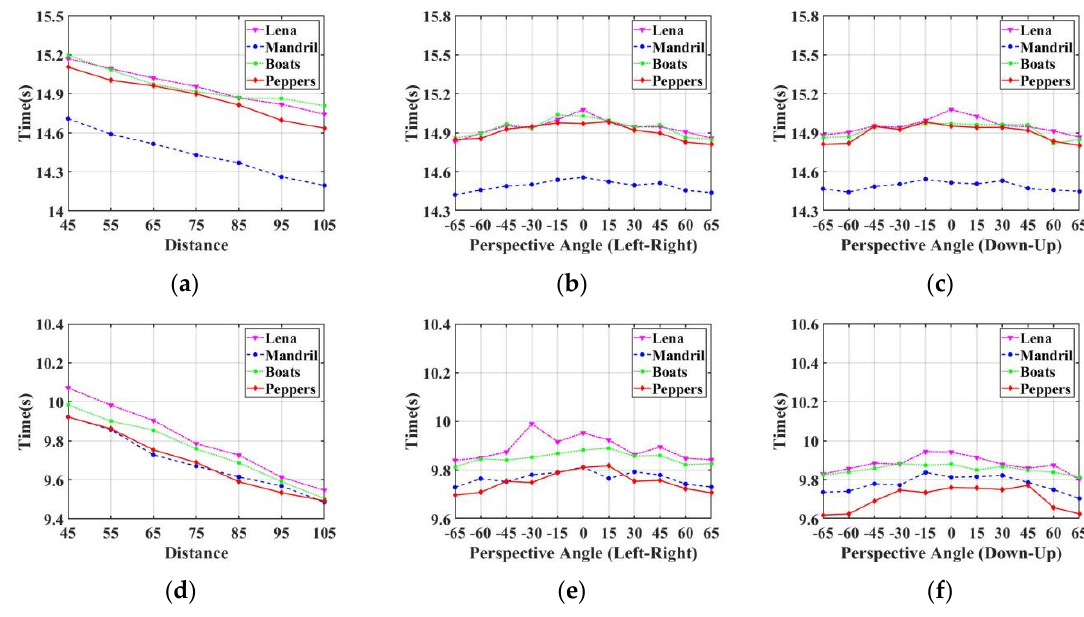
Figure 13. Comparison of the watermark extraction time at different capturing distances and angles: ( a – c ) Watermark extraction time of Fang et al. [10] with different capturing distances, different horizontal angles, and different vertical angles, respectively; ( d – f ) Watermark extraction time of the proposed algorithm with different capturing distances, different horizontal angles, and different vertical angles, respectively.